Question: What does this figure show? Answer in one sentence.
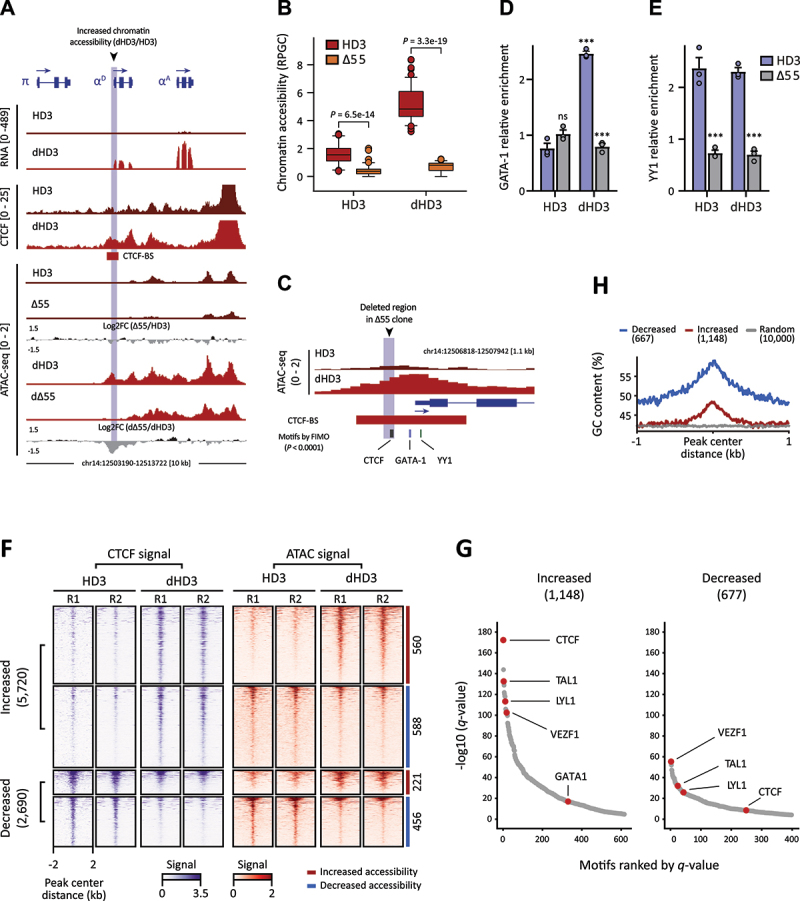
Answer: Disruption of the CTCF-BS impairs local chromatin accessibility. (A) Genomic view of the chicken α-globin locus showing signal tracks for gene expression (RNA-seq), CTCF binding (ChIP-seq), and chromatin accessibility (ATAC-seq). Differences in ATAC-seq signals are shown as log2 fold change (log2FC) of the specified comparisons. The black arrow indicates the differential accessibility site detected in HD3 relative to dHD3. (B) Box plot showing the normalized raw ATAC-seq signal counts (reads per genomic content) at the α D promoter region, as highlighted in panel A. Significance ( p -value) was determined using a two-sided Mann‑Whitney U test. (C) Binding motifs detected by FIMO are located downstream from the CTCF motif and overlapping the ATAC-seq signal around the α D TSS. (D-E) YY1 and GATA-1 binding detected by ChIP-qPCR at the CTCF-BS and normalized to IgG. (F) Heatmaps of ChIP-seq for CTCF and ATAC-seq signal profiles for differentially CTCF-bound sites in undifferentiated (HD3) and differentiated (dHD3) cells. Changes in chromatin accessibility were detected by FDR < 0.05; log2FC ± 1. (G) Motif enrichment analysis of increased CTCF binding sites that exhibit differential changes in chromatin accessibility. (H) Profile plot of GC-content percentage centered on differentially CTCF-bound sites that exhibit differential changes in chromatin accessibility. Data represent the mean ± SEM of three biological replicates. Significance determined by an unpaired t -test as follows: (ns) not significant; * p < 0.05, ** p < 0.01, and *** p < 0.001.